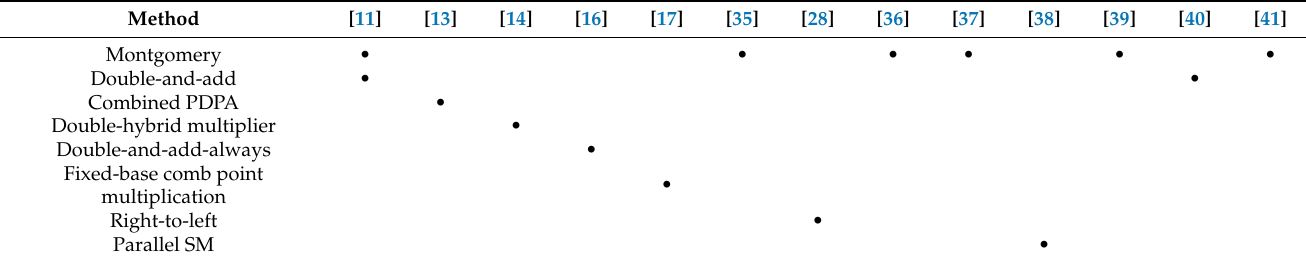
Table 10. Elliptic Curve Point Multiplication (ECPM)